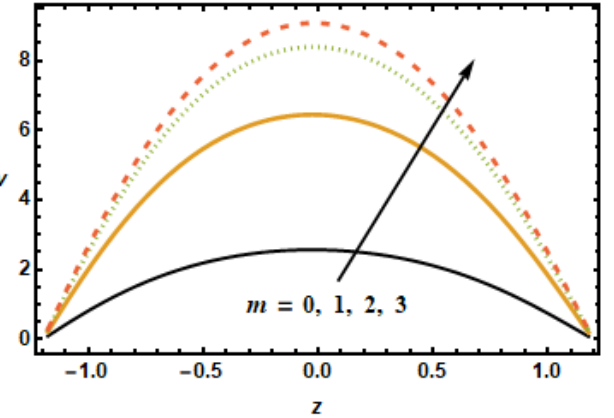
v on Hall parameter